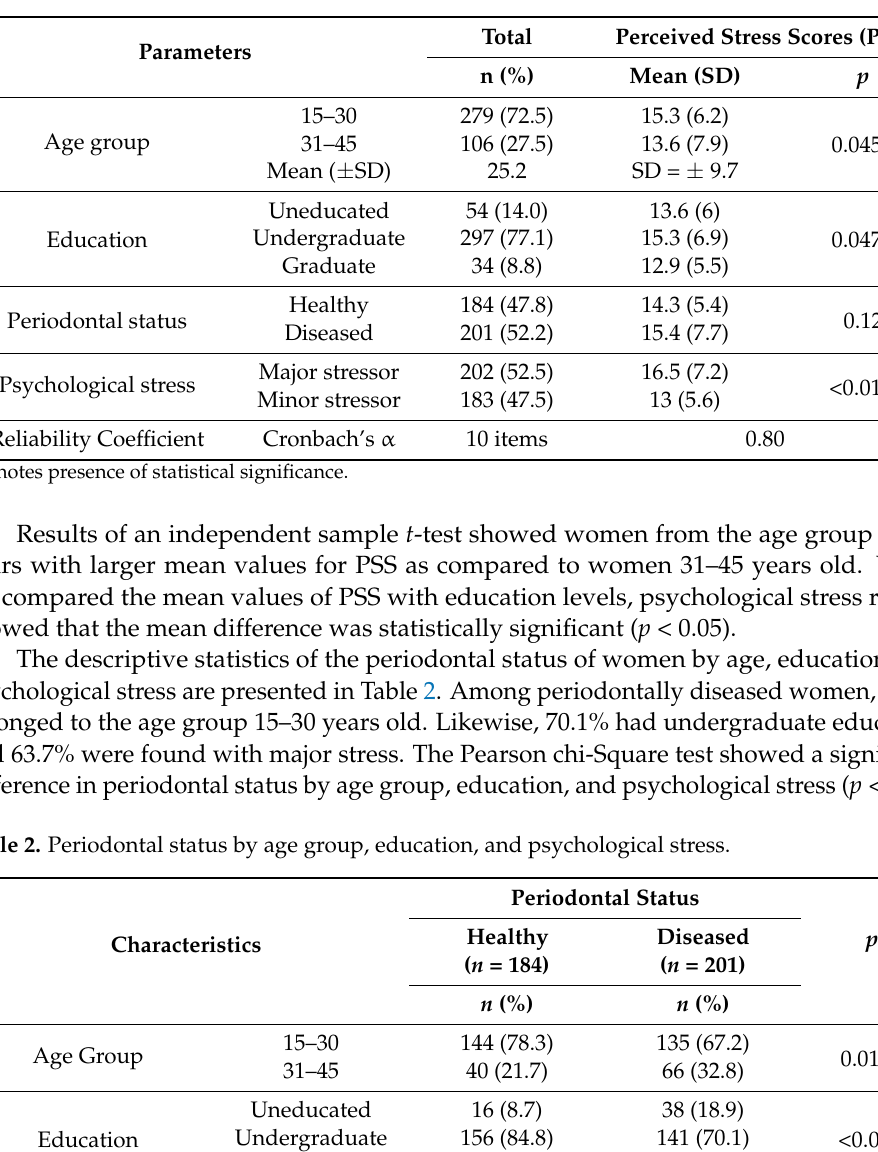
Table 1. Mean comparison of PPS with baseline characteristics ( n = 385).